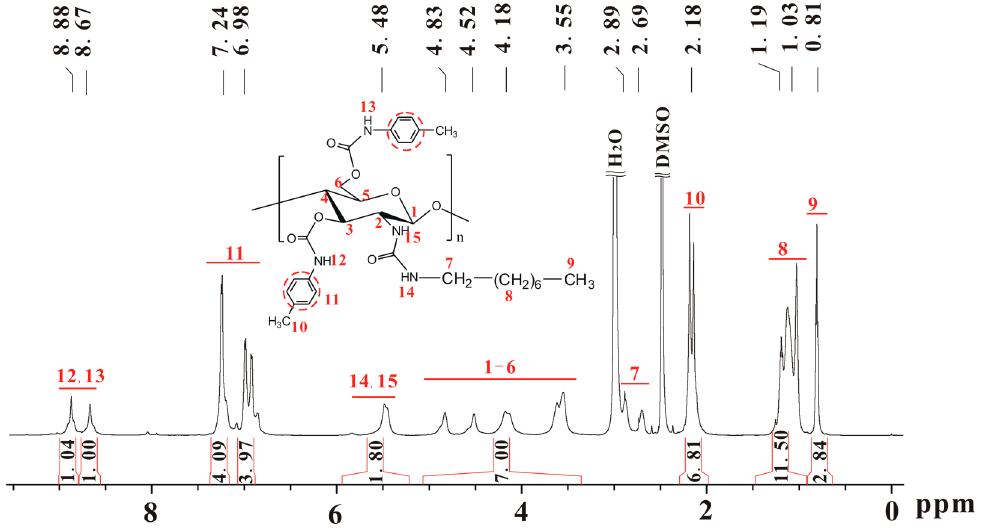
Figure 1. 1 H-NMR spectrum of chitosan bis(4-methylphenylcarbamate)-( n -octyl urea) ( CS 1 ).